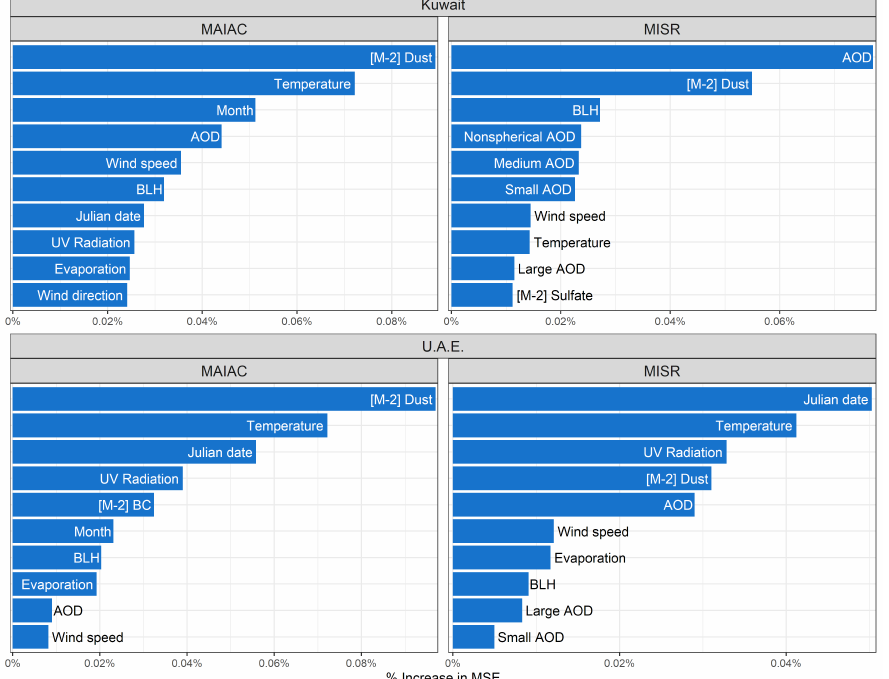
Figure 6. The top 10 most important variables for the random forest models based on monitors in Kuwait using MAIAC AOD ( top left ) and MISR AOD ( top right ) and in the U.A.E. using MAIAC AOD ( bottom left ) and MISR AOD ( bottom right ), as measured by increase in MSE when